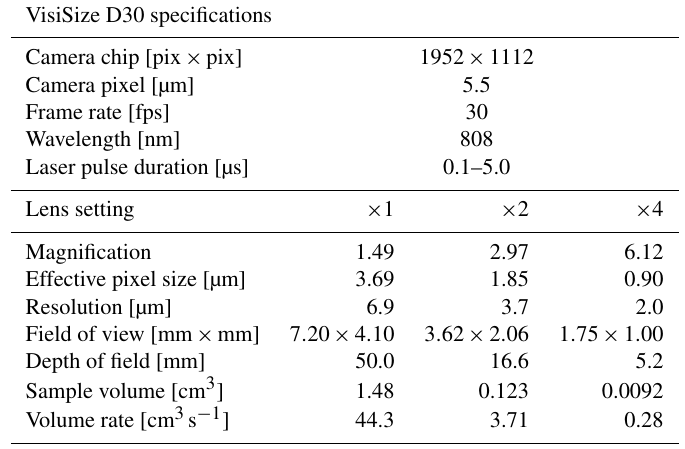
Table 1. Properties of the VisiSize D30 system for three different lens magnification settings provided by Oxford Lasers Ltd.